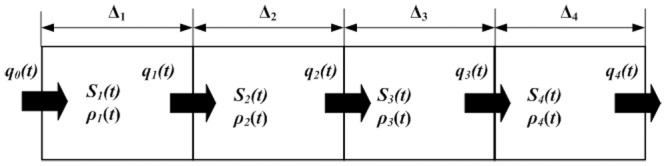
A typical segmented motorway.